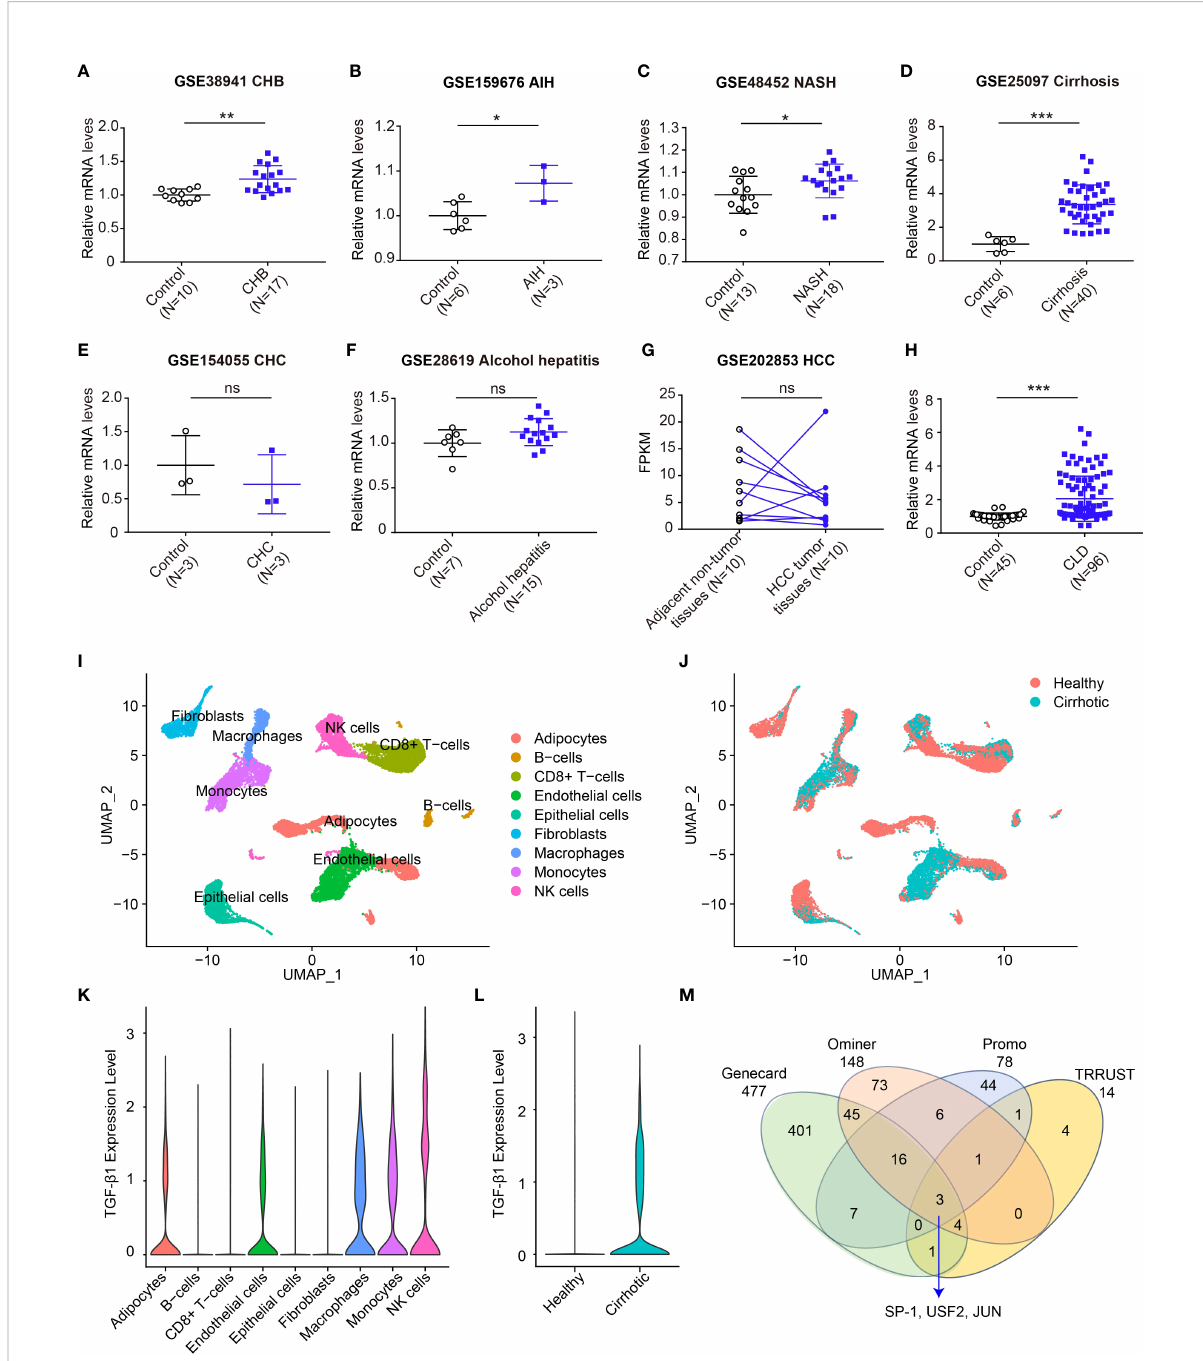
FIGURE 5 Expression of TGF- b 1 mRNA increases in CLDs. (A-F) Transcript levels of TGF- b 1 in healthy individuals or patients with CHB ( A , GSE38941), AIH ( B , GSE159676), NASH ( C , GSE48452), cirrhosis ( D , GSE25097), CHC ( E , GSE154055), and alcohol hepatitis ( F , GSE28619); (G) Transcript levels of TGF- b 1 in adjacent non-tumor or HCC tumor (GSE202853); (H) Transcript levels of TGF- b 1 in healthy individuals or patients with CLDs; (I, J) UMAP plot showing all liver non-parenchymal cells dependent on the cluster (I) and dependent on the origin (J) ; (K) TGF- b 1 gene expression in all cell clusters; (L) TGF- b 1 gene expression in healthy individuals and liver cirrhosis patients; (M) The transcription factor analysis of TGF- b 1. Data are mean±SD. * P <0.05, ** P <0.01, and *** P <0.001 vs. Control. ns, not signi fi cant. Signi fi cance was calculated by two-tailed unpaired Student ’ s t